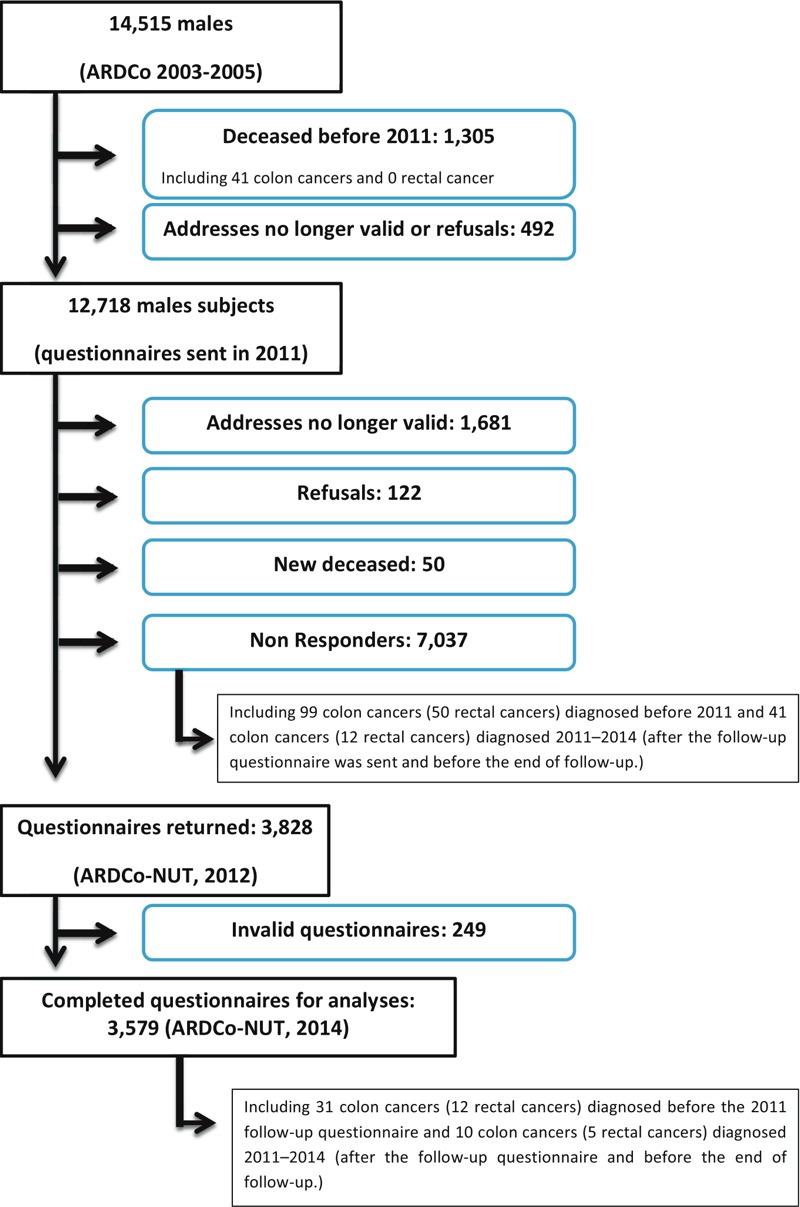
Flow-chart of the Asbestos-Related Diseases COhort (ARDCo) cohort and the ARDCo‑Nut subsample.